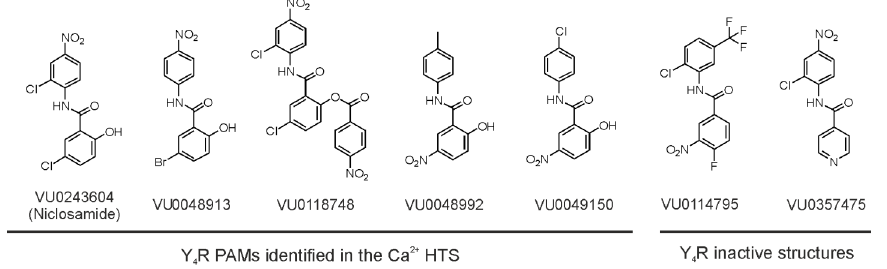
Fig 2. Structures of Y 4 R PAMs identified by HTS and inactive control compounds chosen for further characterization of Y 4 R PAM activity and YR subtype